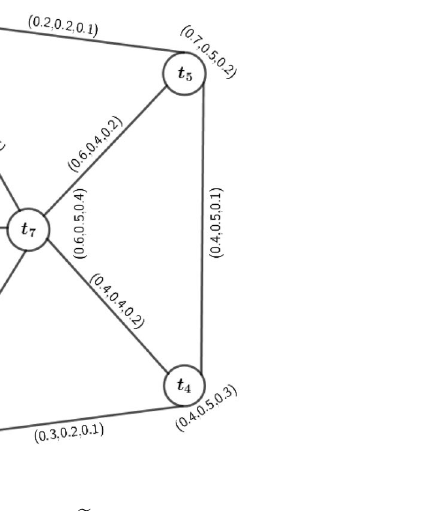
Figure 13. 3-polar fuzzy model road network